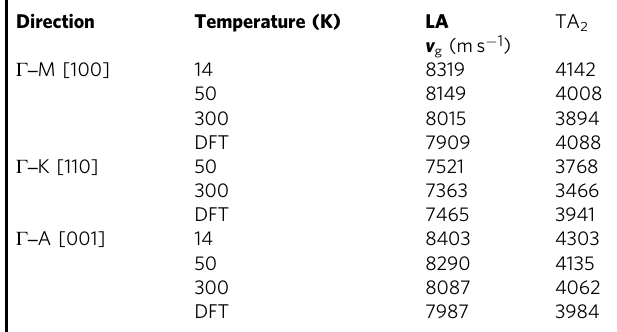
Table 1 Group velocity ( v g ) of the longitudinal acoustic (LA) and the second transverse acoustic (TA 2 ) phonons along the high symmetry directions from experimental data. Direction